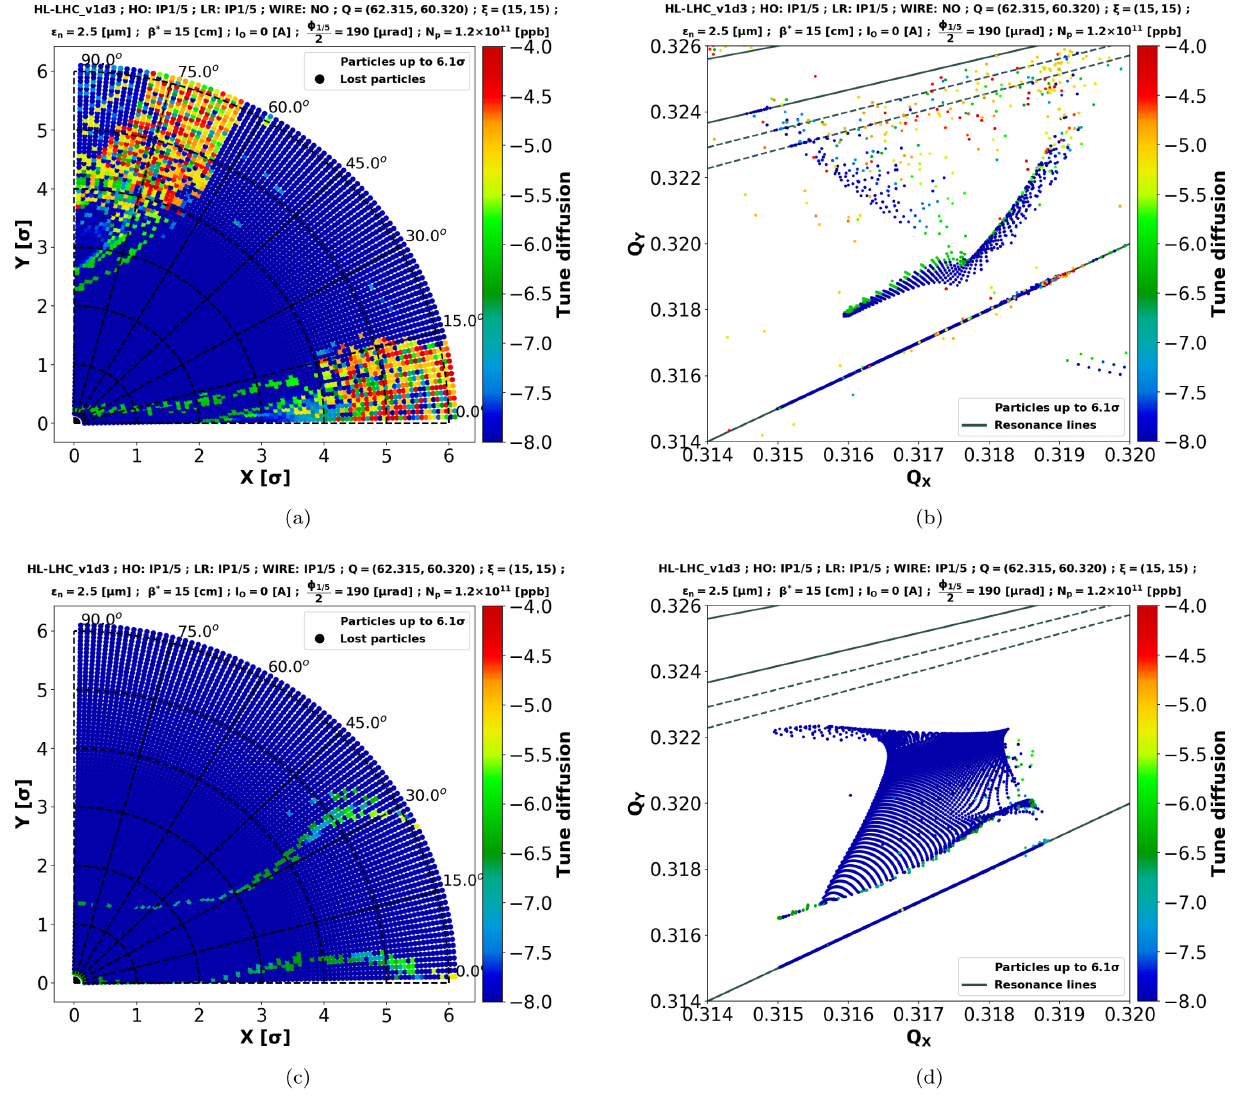
FIG. 8. HL-LHC at the end of luminosity leveling with half crossing angle at IP1 and IP5 190 μ rad and N p ¼ 1 . 2 × 10 11 ppb. (a) and (c) for particles up to 6 . 1 σ the tune diffusion of the cases without and with wire compensator, respectively. (b) and (d) for particles up to 6 . 1 σ the footprint and the tune diffusion of the cases without and with wire compensator,